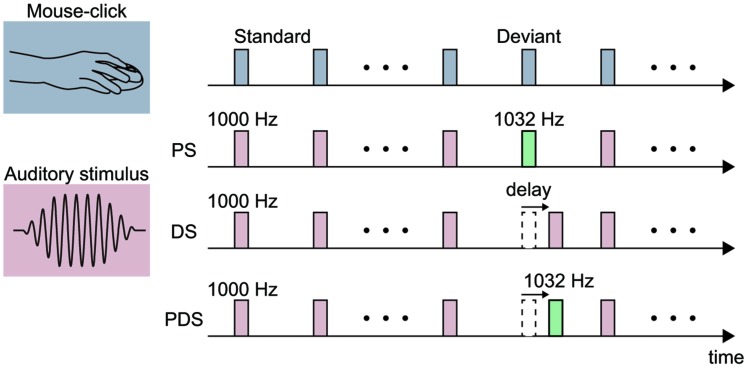
Schematic illustration of the experimental stimuli. Each stimulus was either elicited by a mouse-click performed by the participant (action condition; top) or presented passively with a fixed (1 s) interval (non-action condition in Experiments 1 and 2). A pitch-deviant stimulus (PS) was used in Experiments 1 and 3. The PS was a 1032-Hz pure tone (presentation rate 20%) and the standard stimulus was a 1000-Hz pure tone (80%). Delayed stimuli (DS) were used in Experiments 2–4. The delay length was fixed at 150 ms in Experiments 2 and 3, and varied from 100 to 400 ms in Experiment 4. A pitch-deviant delayed stimulus (PDS) was used in Experiment 3. Specifically, this was a 1032-Hz pure tone presented with a 150 ms delay with respect to the mouse-click.